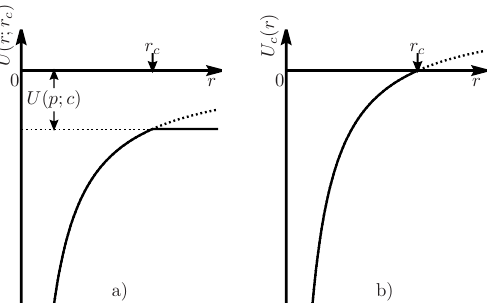
Figure 1. Behaviour of the potentials U ( r ; r c ) and U c ( r ) , where r c is the cut-off parameter. In ( a ) the potetntial goes to the mean potential energy of an electron in the considered hydrogen plasma U p ; c , and in ( b ), the value of U p ; c is taken as zero energy, i.e., U c = U ( r ; r c ) − U p ; c , in the more applicable form used here.